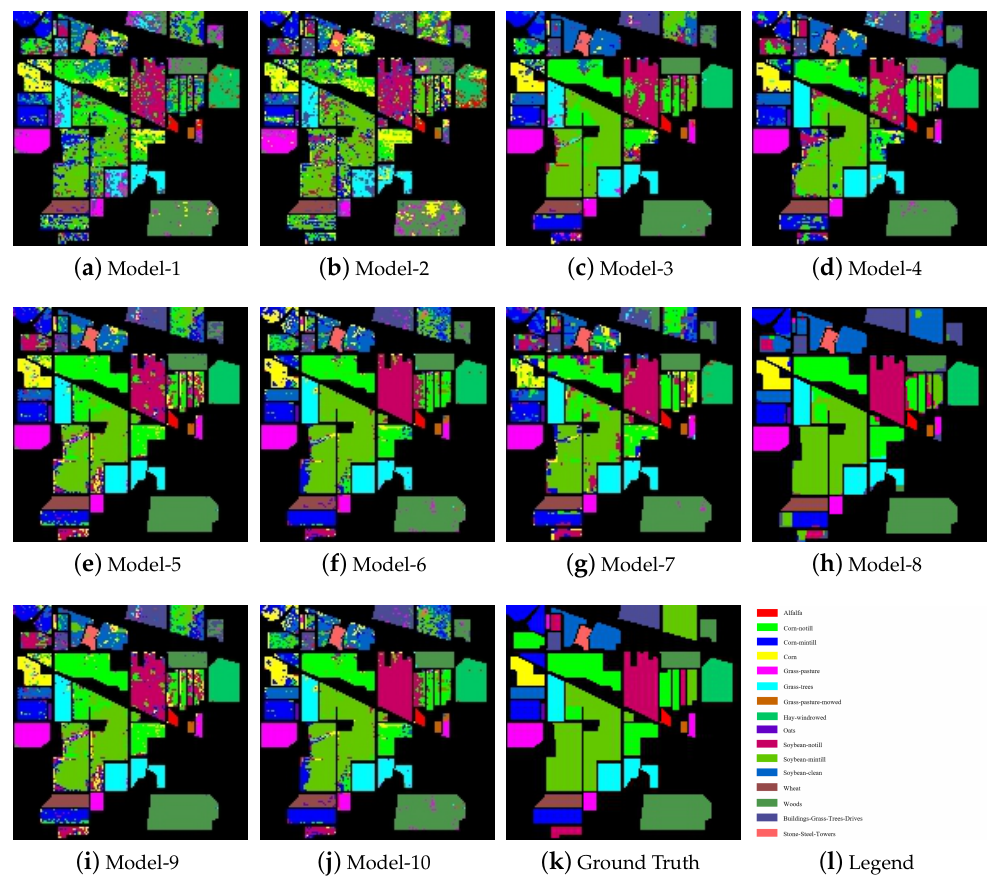
Figure 5. Classification maps of the models on the Indian Pines dataset.